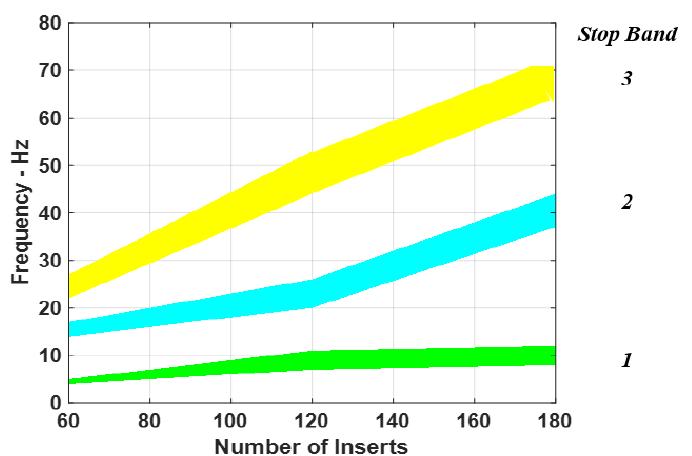
Figure 10. Effect of number of periodic inserts on the spectral width of the different stop bands of a passive periodic drill-string for the transverse vibration.